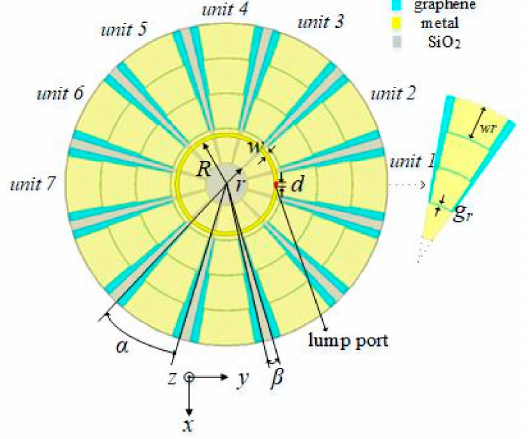
Figure 2. Top view of the loop antenna with the graphene-based high impedance surface